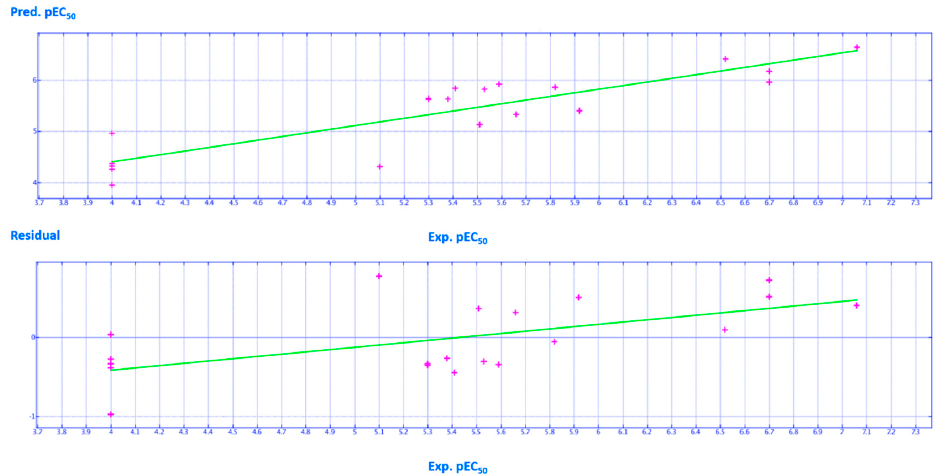
Figure 17. Distribution of the predicted (Pred.pEC 50 ) and experimental (Exp.pEC 50 ) potency values of the test set compounds (by magenta crosses). Residual values are also reported, calculated as the difference between the Exp.pEC 50 and the Pred.pEC 50 .